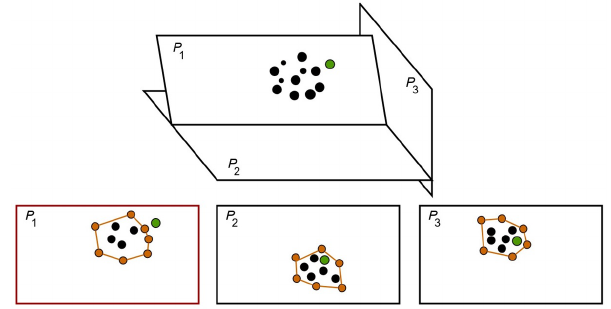
Figure 1. Projections of a 3-D data cloud (black), CHs of each 2-D space (orange) and a new